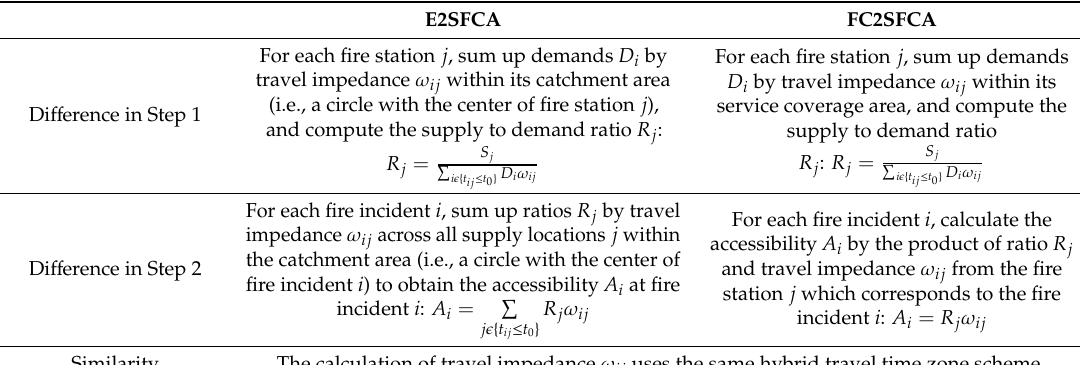
Table 1. Comparison of enhanced two-step floating catchment area (E2SFCA) and FC2SFCA for measuring the accessibility of fire